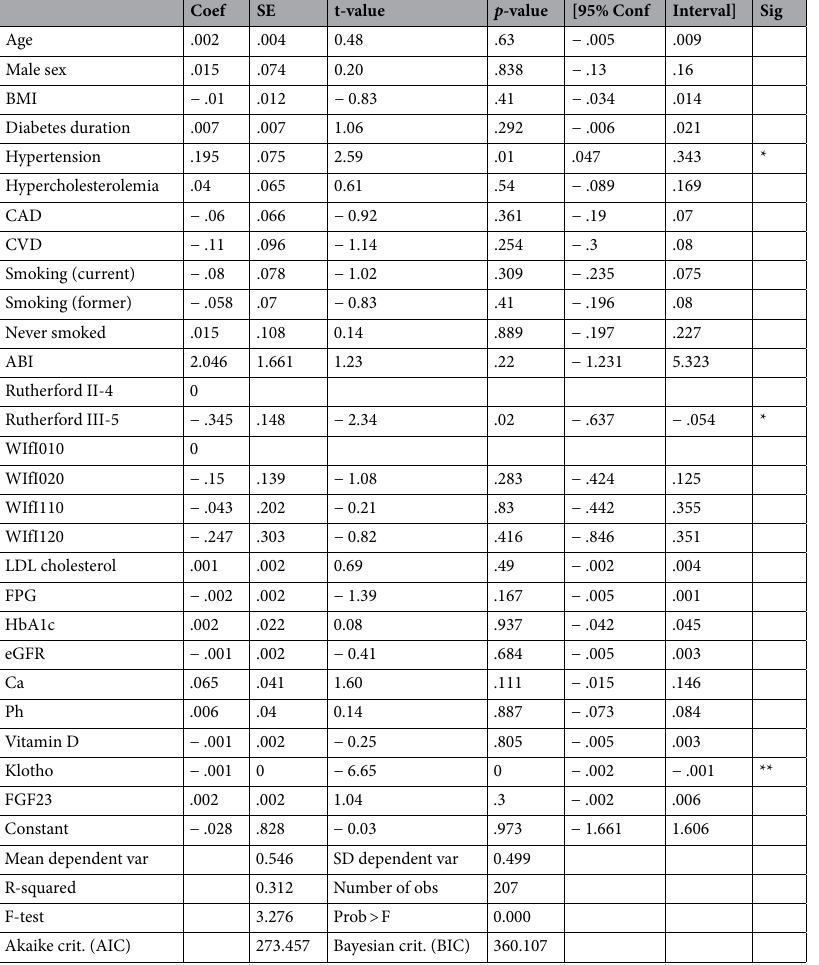
Table 5. Multivariable logistic regression for MALE. ** p < .01, * p <